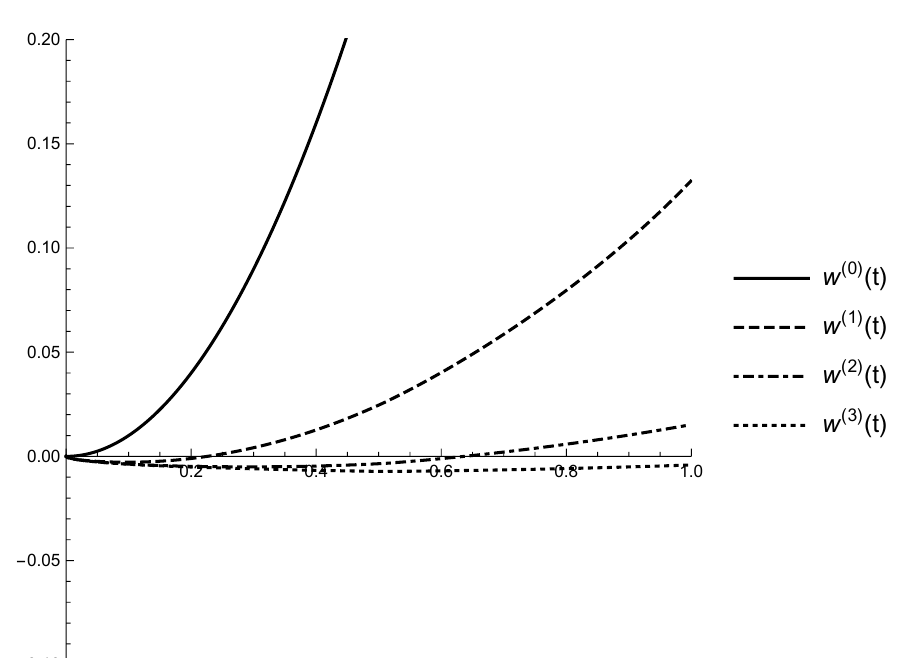
Figure 5. Graphs of the successive upper approximations w ( n ) ( t ) , n = 0, 1, 2, 3, on the interval [ 0,1 ] .